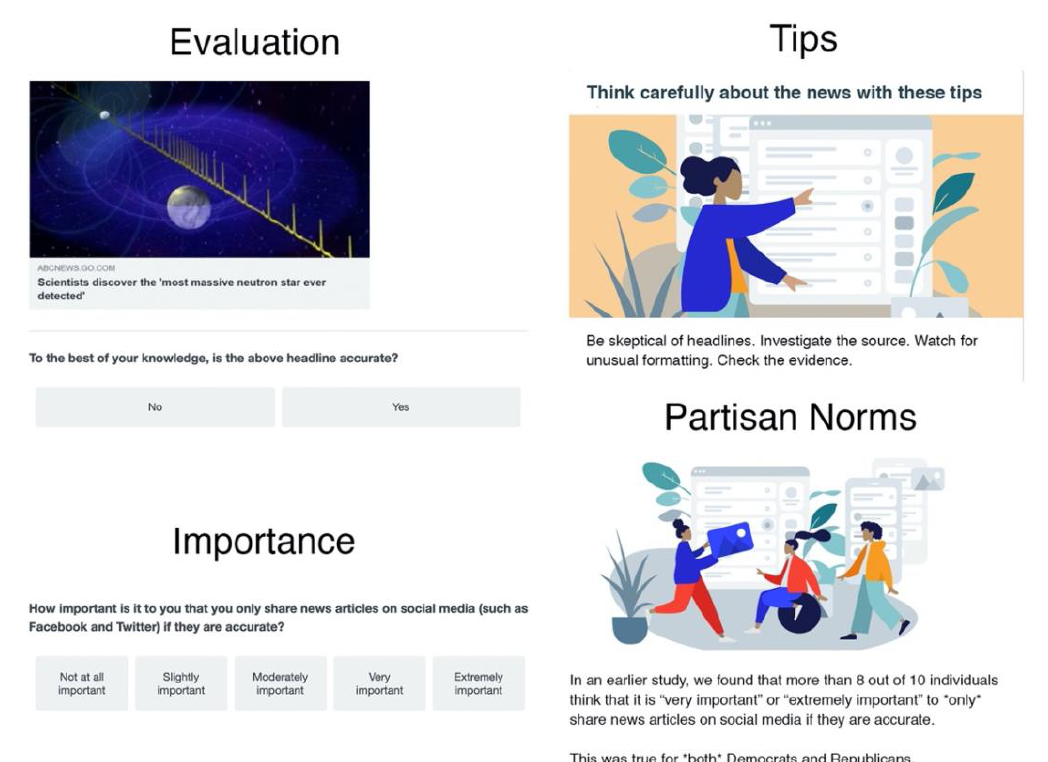
Figure 2. Sample materials for the evaluation treatment, importance treatment, tips treatment, and partisan norms treatment. The generic norms treatment had the same image as the partisan norms treatment but used the text “Did you know, over 80% of past su rvey respondents say it’s important to think about accuracy before sharing news on social